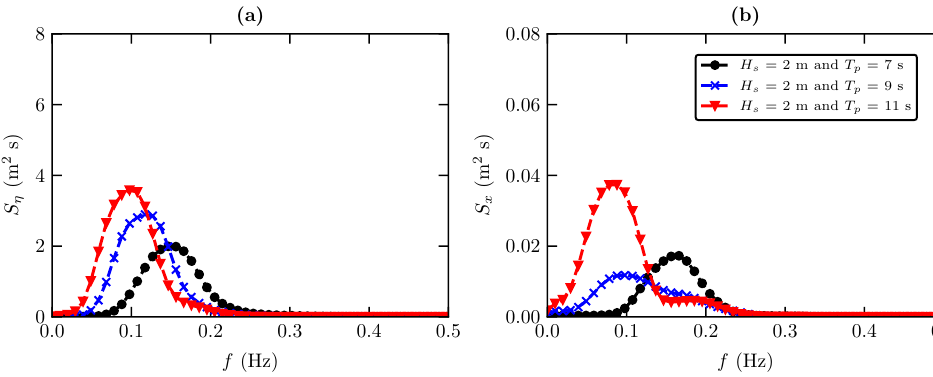
Figure 13. Power spectra of ( a ) free-surface elevation measured at x = 220 m and of ( b ) the horizontal position of the hydraulic PTO system for H s = 2 m and T p = 7, 9 and 11 s.